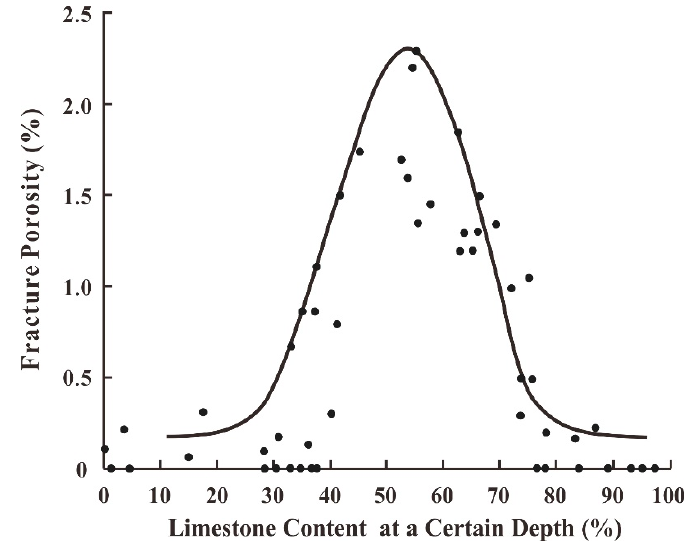
Figure 4. The relationship between fracture porosity and lime content.